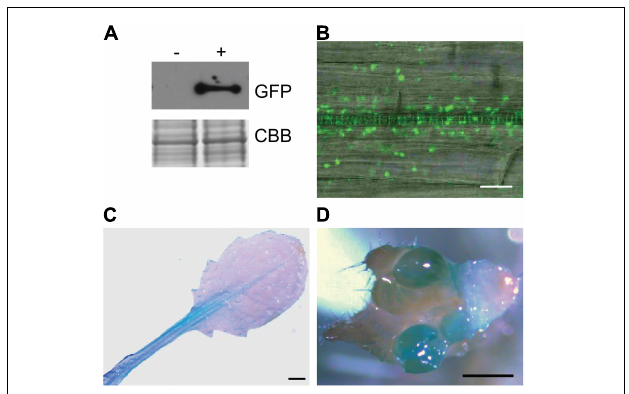
FIGURE 3 | Colonization of the endophytic strain A4 (A) Western blot analysis of A4 transformant expressing GFP. Coomassie stain (CBB) shows equivalent protein loading. An antibody against GFP was used for visualization, and non-transformant A4 strain as a negative control. Seven days after inoculation of Arabidopsis thaliana seedlings, (B) GFP-expressing A4 inside the primary root. Scale bar = 20 µ m. Histochemical GUS activity of A4 strain in (C) leaf tissue and (D) inflorescence. Scale bar = 1 mm.